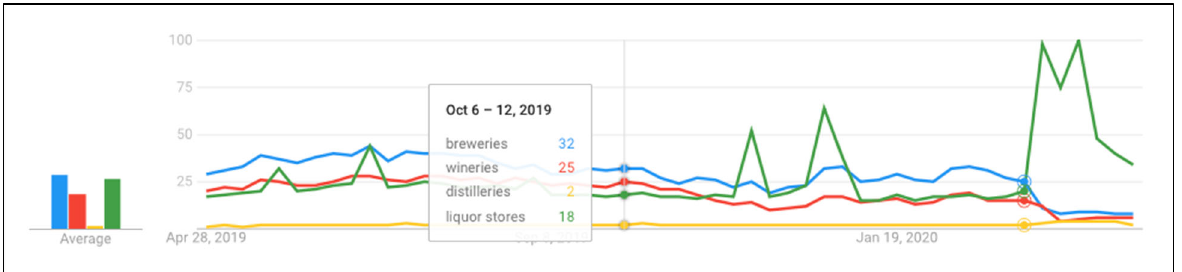
Figure 5b. Search Intensity for Breweries, Wineries, and Distilleries with Liquor Stores